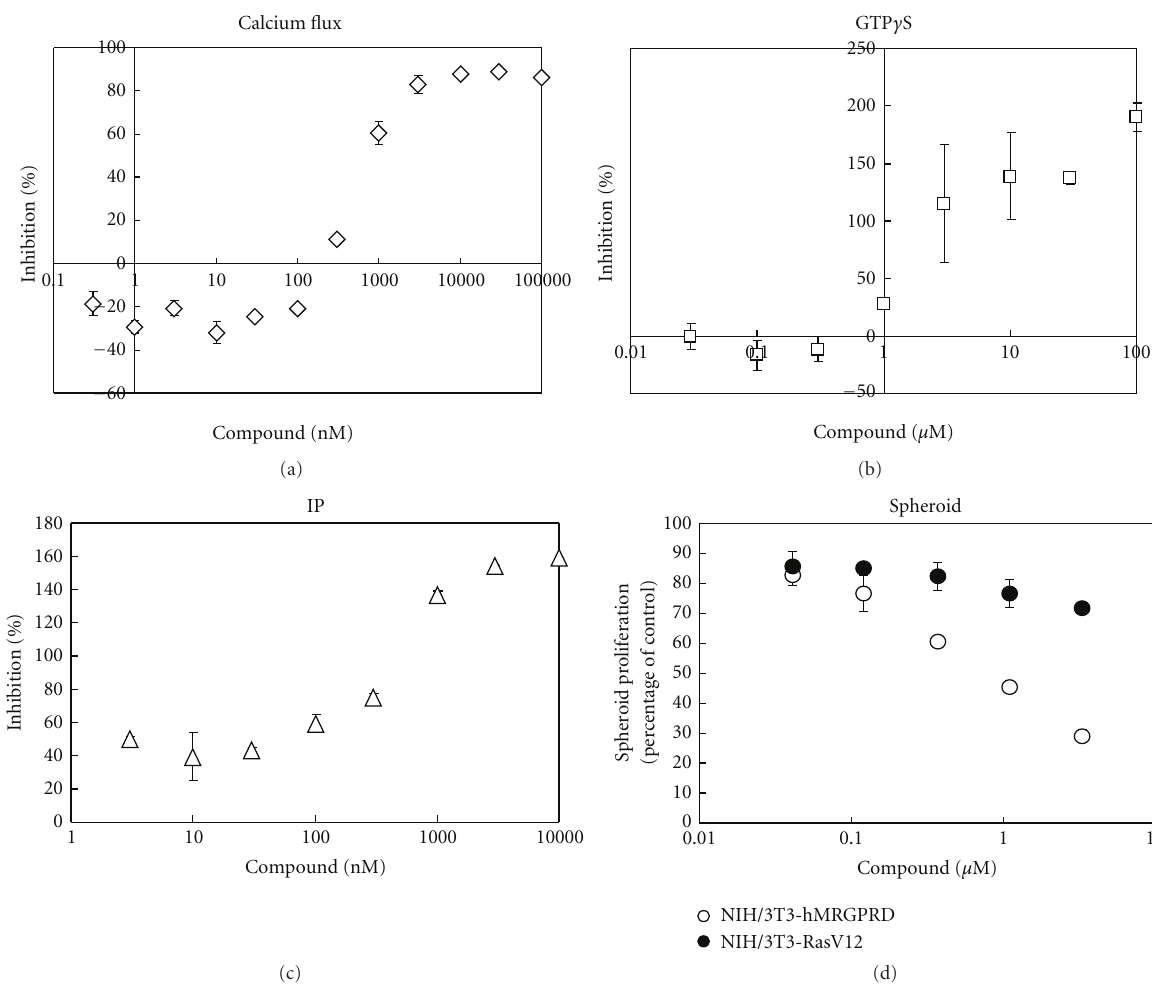
Figure 5: Inhibitory e ff ects of MU-6840 on MRGPRD. Representative dose-dependent inhibition curves in (a) calcium flux assay, (b) GTP γ S binding assay, (c) IP assay, and (d) spheroid assay by MU-6840 are shown. Each value expresses the percentage of control with no compound present. The results are the average of three independent